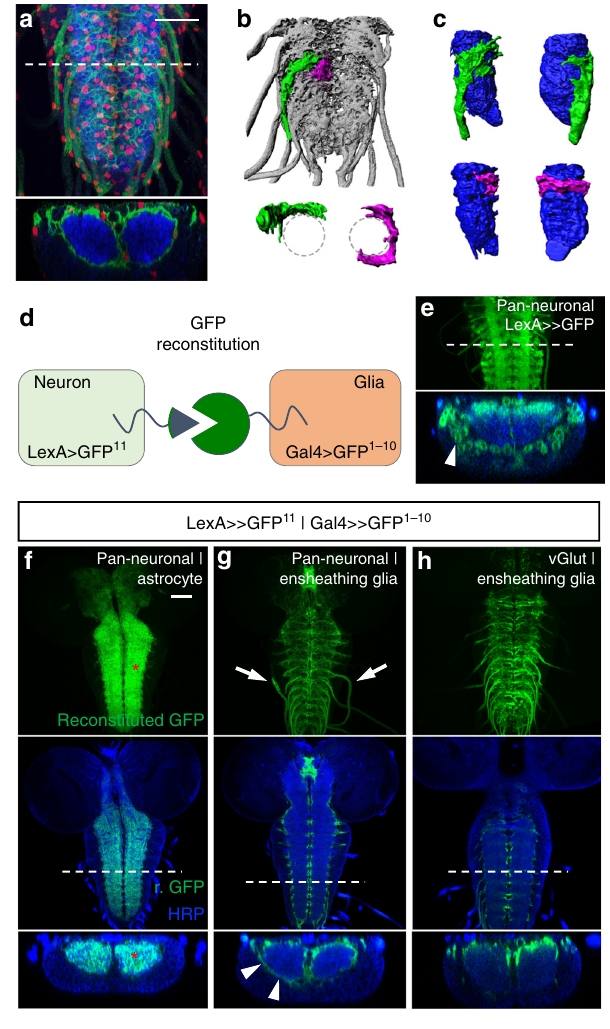
cells in each hemi-segment. Two of these cells appear to tile up around the neuropil forming an internal barrier-like sheath between the CNS cortex and the neuropil. The other two cells addition- towards the CNS/peripheral nervous system exit zone.